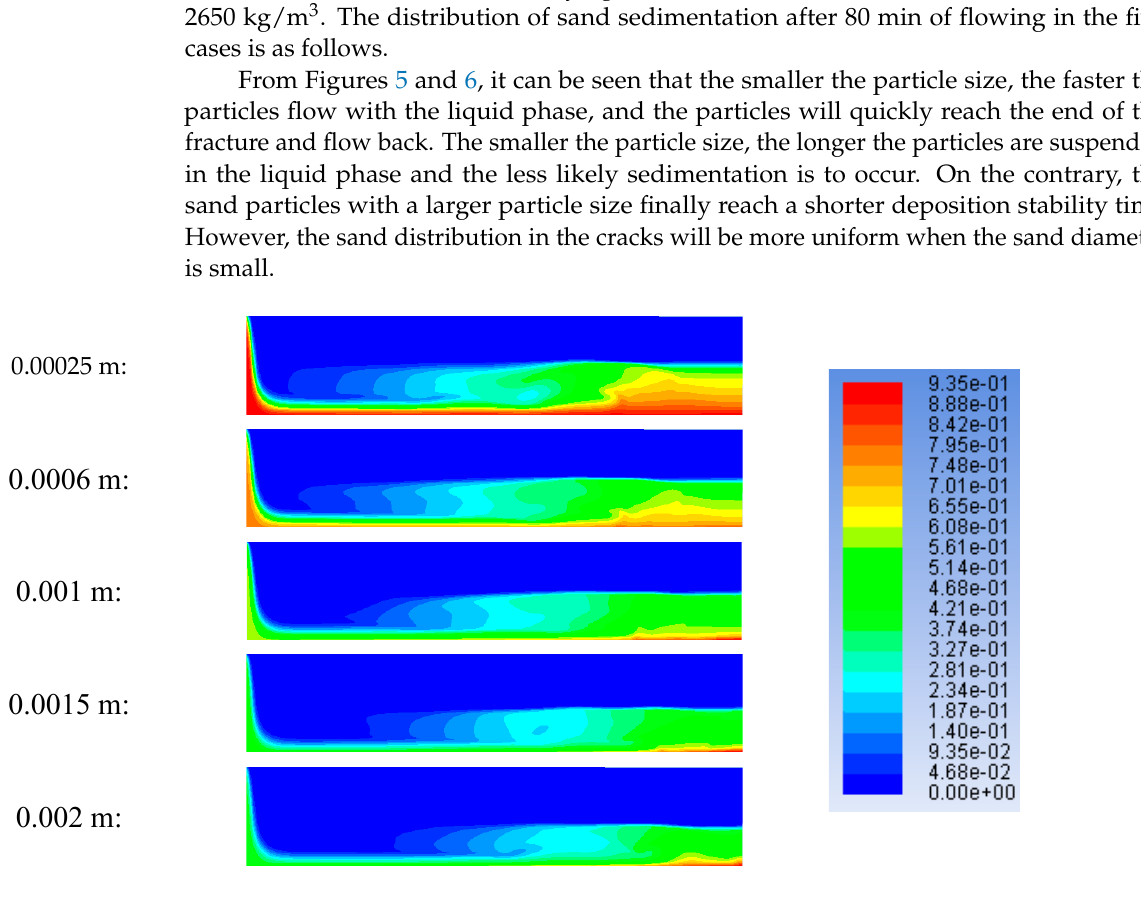
Figure 5. Gravel settlement diagram with different particle sizes.